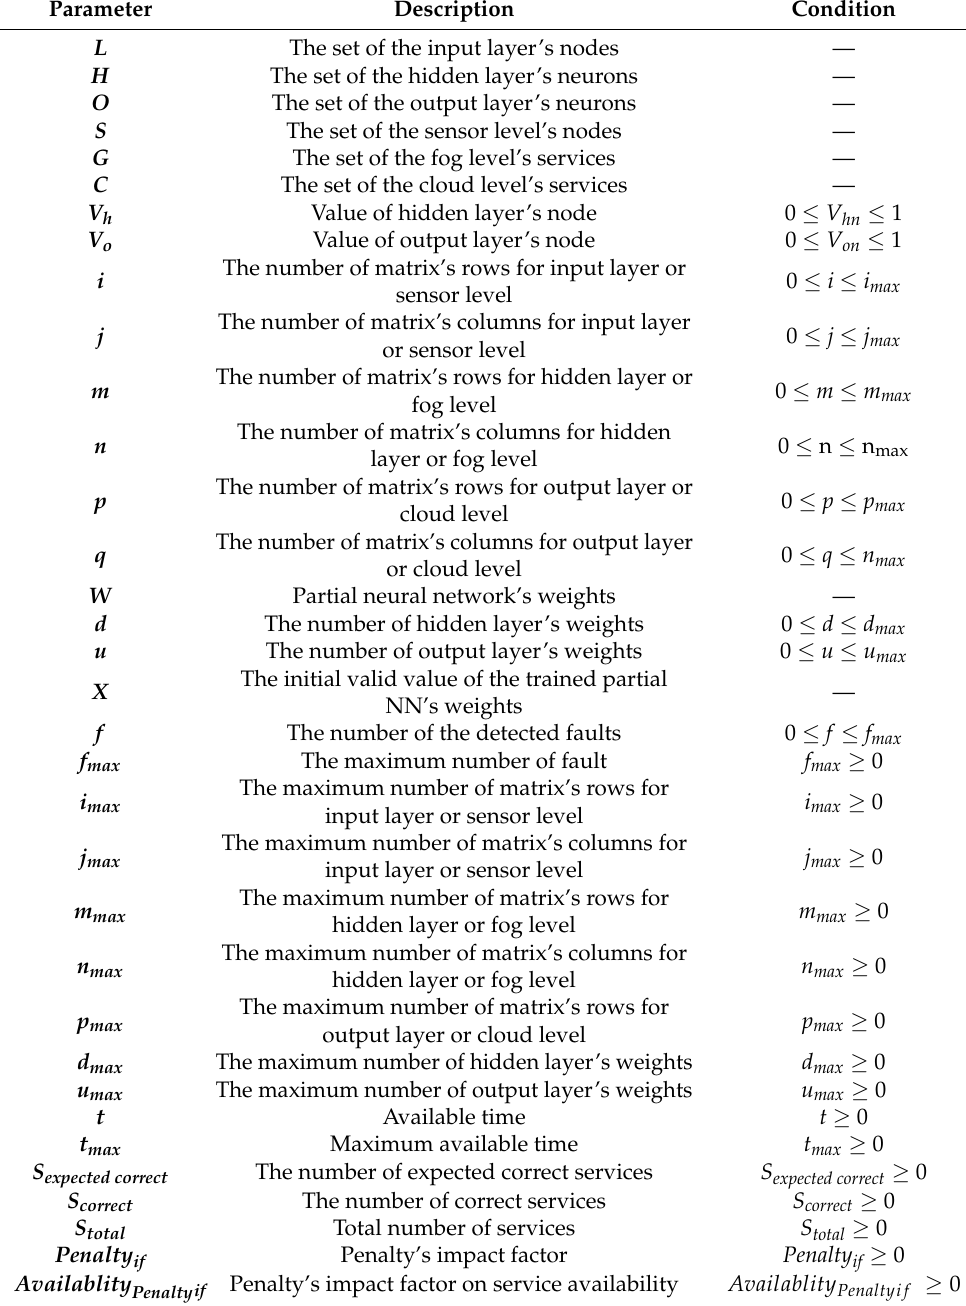
Table 2. The existing parameters in